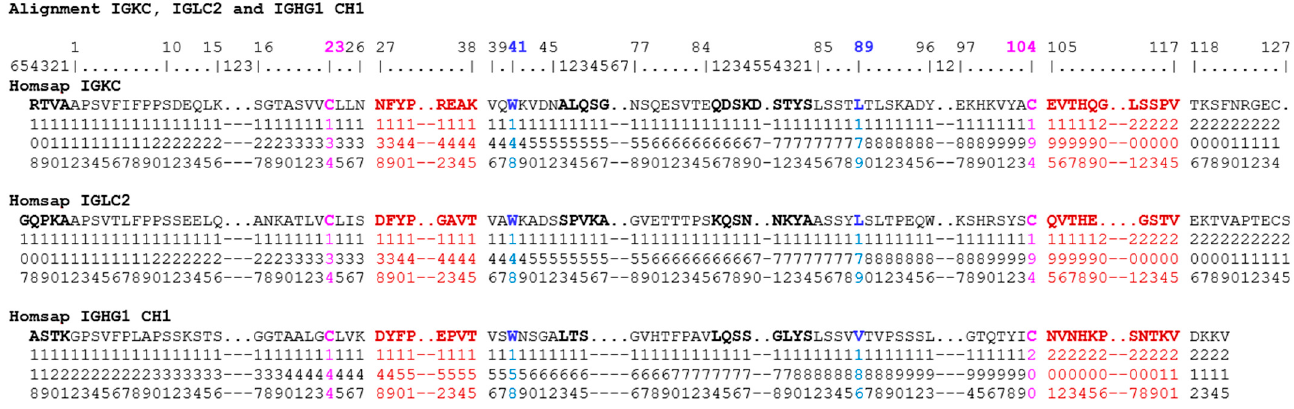
Figure 7. Correspondence between the Homo sapiens IGKC, IGLC2 and IGHG1 CH1 sequences, based on the IMGT unique numbering [68] and the Eu positions [97]. The first amino acid of each sequence results from the splicing. The IGHG1 CH1 chosen as the CH representative is from Figure 5A. The IMGT unique numbering is shown on the top horizontal line one with additional IMGT positions on line two. Amino acids at these additional positions (by comparison to the V-domain IMGT unique numbering [67]) are highlighted in bold in the Homsap IGKC, IGLC2 and IGHG1 CH1 sequences. The Eu numbers are read vertically (on three lines top to down) at each position below the amino acid sequences. For example, the first amino acid of IGKC R1.4 corresponds to Eu